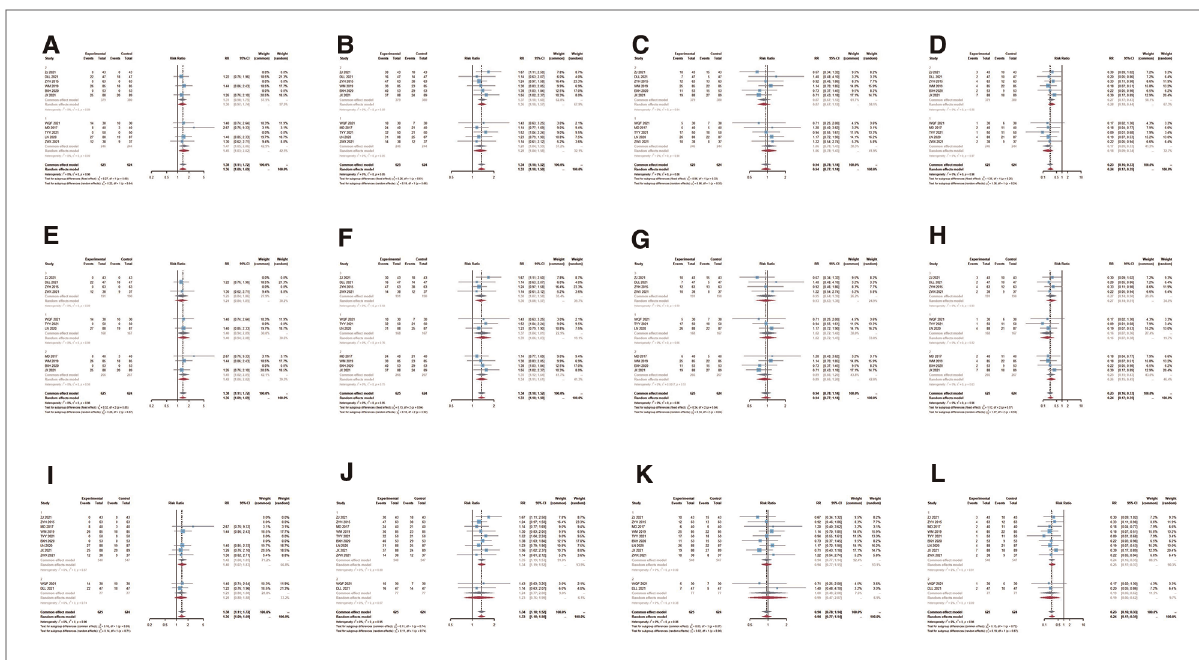
FIGURE 5 Subgroup analysis forest plot based on the treatment course, different TCM+DNG and different controls of treatment effect rates. ( A – D ) Subgroup analysis forest plot based on the treatment course of treatment effect rates. ( E – H ) Subgroup analysis forest plot based on different TCM+DNG of treatment effect rates. ( I – K ) Subgroup analysis forest plot based on different control of treatment effect rates. ( A,E,I ) cure rate; ( B,F,J ) remarkable effects rate; ( C,G,K ) effective rate; ( D,H,L ) invalid rates. Signi fi cant differences were not observed between the